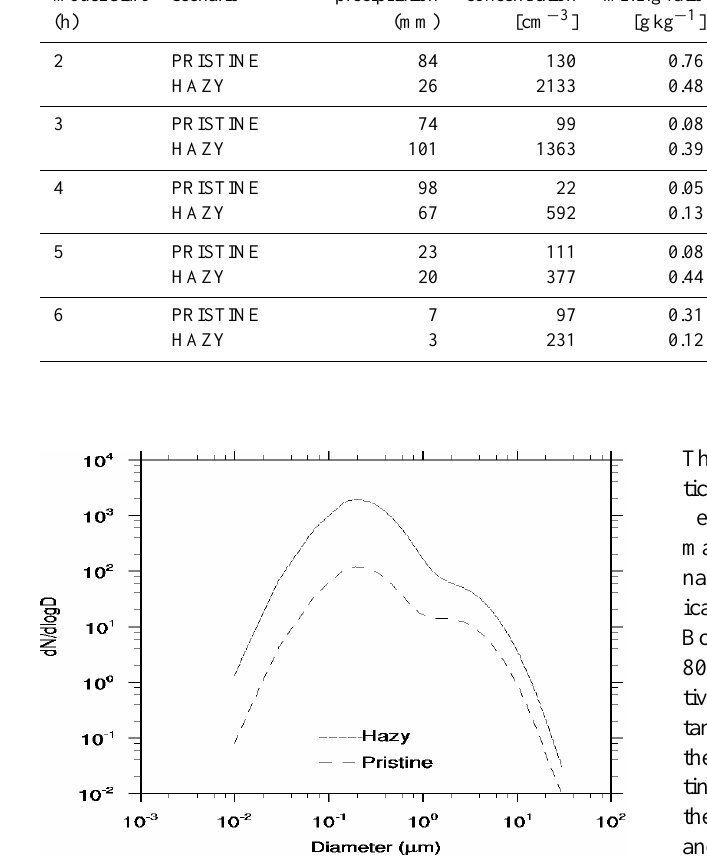
Fig. 2. Distribution of the available aerosol